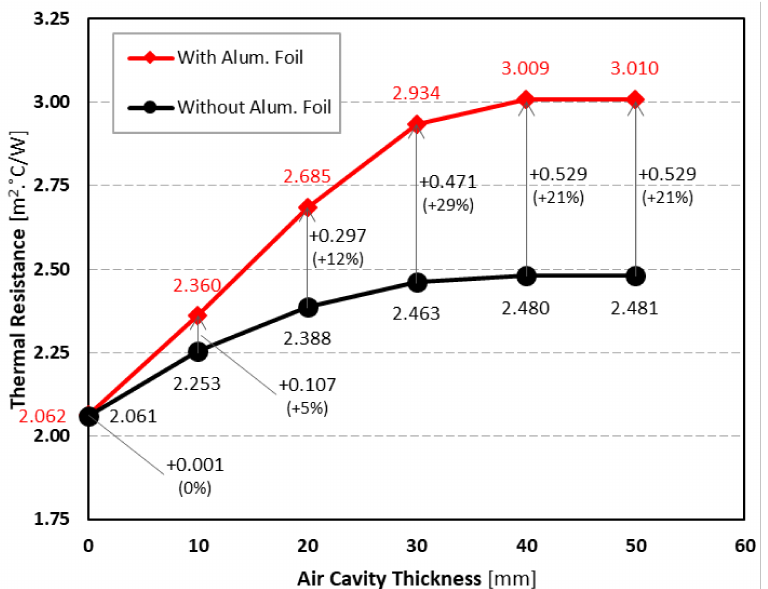
Figure 6. Measured conductive thermal resistances of a double pane LSF wall, with different air cavity thicknesses, with and without a reflective aluminium